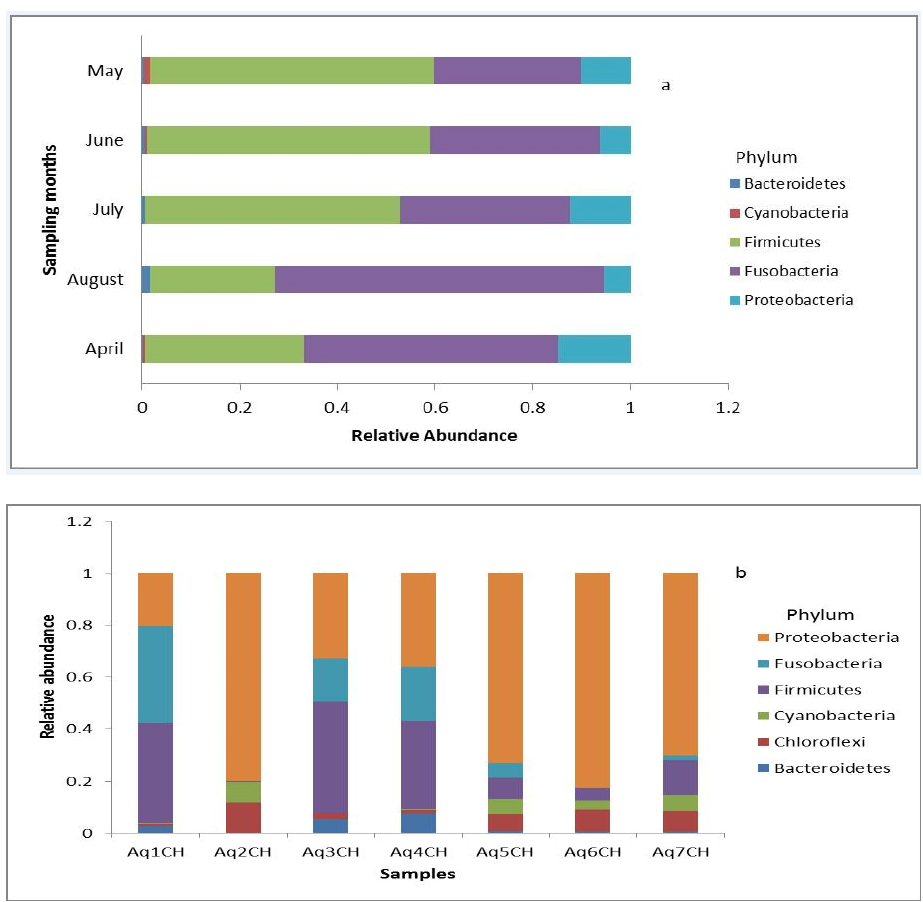
Figure 2. Taxonomic composition of the bacterial community at the phylum level using a stacked plot. ( a ) Lake Tana samples shown on a monthly basis. ( b ) Bahir Dar aquaculture facility centre samples.